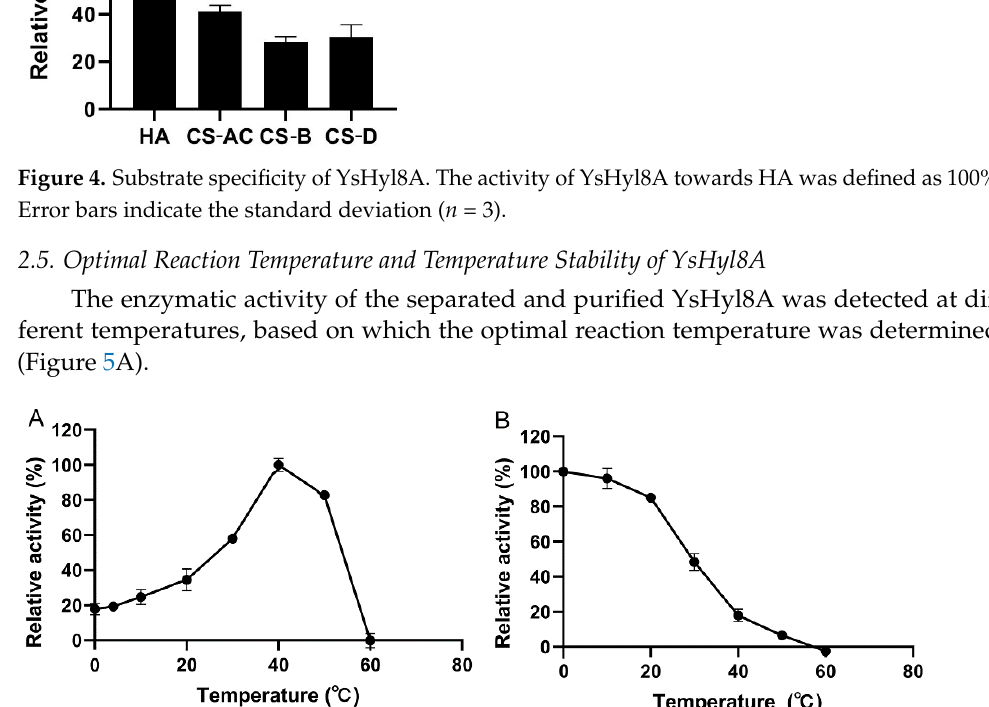
Figure 5. Optimal reaction temperature and temperature stability of YsHyl8A: ( A ) Optimal reaction temperature; ( B ) The temperature stability. The initial activity was defined as 100%. Error bars in- dicate the standard deviation ( n = 3).